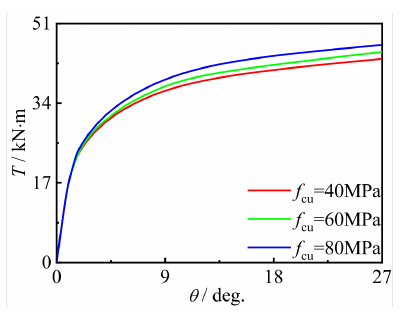
Figure 23. Effect of f cu on T - θ curve.